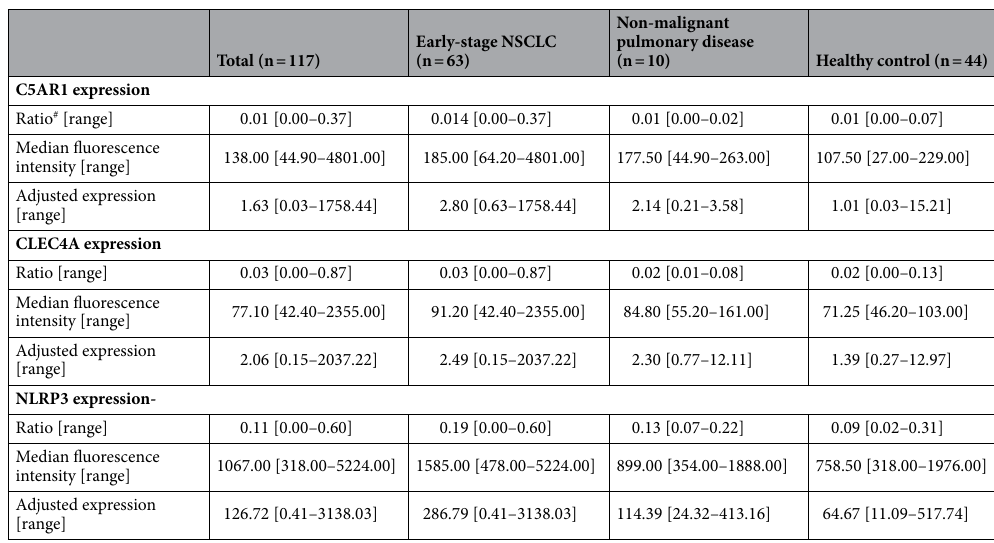
Table 2. Results of C5AR1, CLEC4A and NLRP3 protein expression of circulating T- lymphocyte in study participants. # Ratio calculated by percentage of positive cells in each specific antibody to CD3 + cells. *Adjusted expression calculated by the ratio of each specific antibody multiply by the average